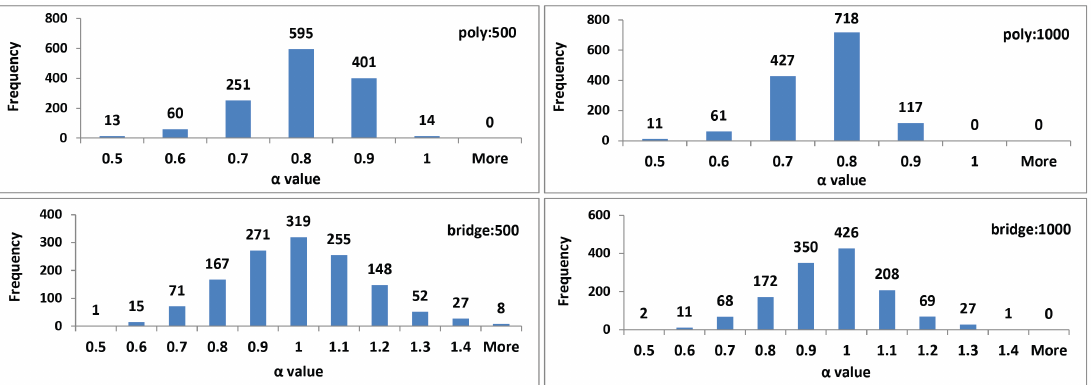
Figure 9. The histogram of α values prepared for the chosen filtering method—SG7—and different parameters of the DFA